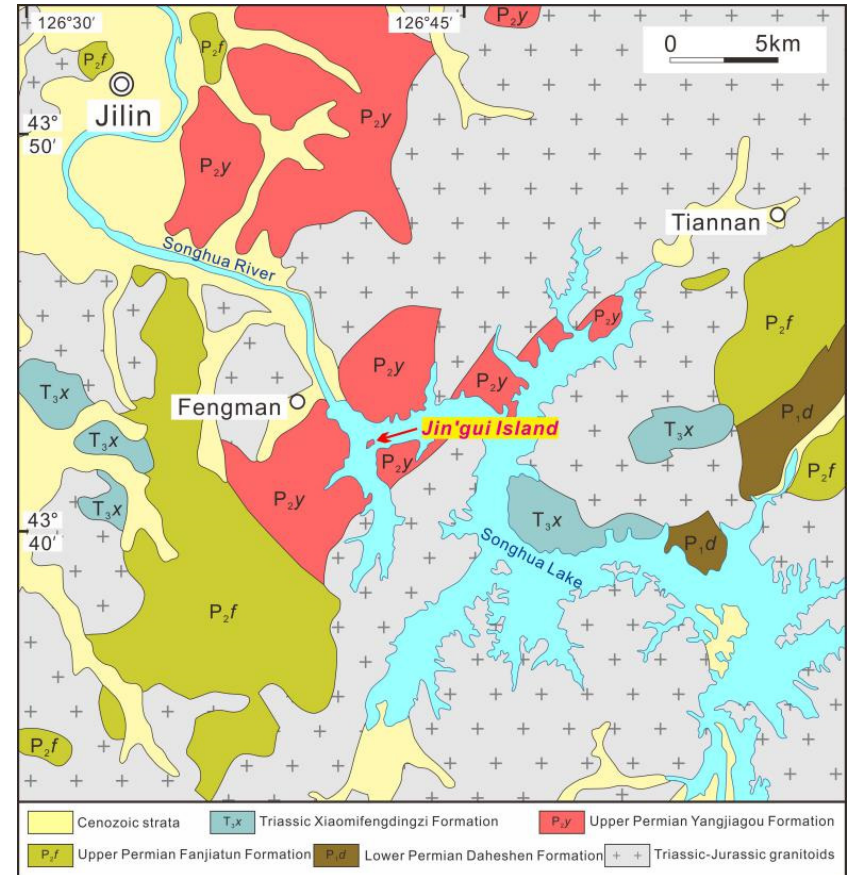
Figure 2. Geological map of the Songhua Lake area.